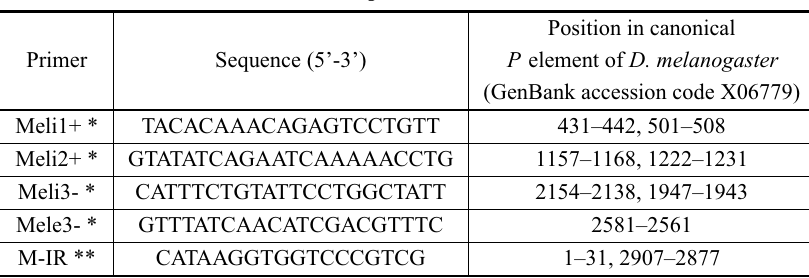
PCR primers used.